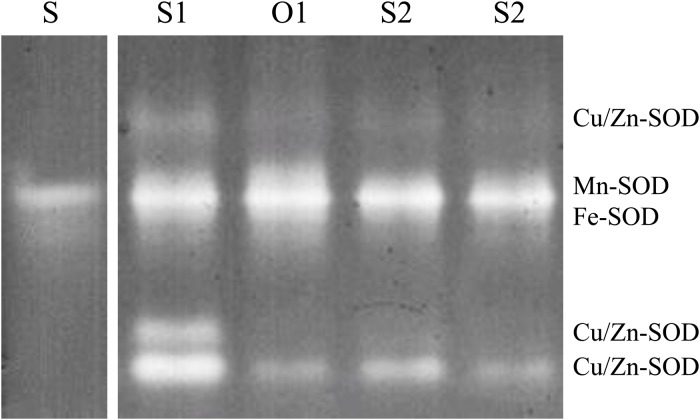
Superoxide dismutase (SOD) activity in the leaves of young orange trees 150 days after Zn application (enriched on 68Zn) in different soils.Legend: Bovine SOD standard (S), ZnSO4 (S1), and ZnO (O1) in the sandy loam soil; ZnSO4 (S2) and ZnO (O2) in the clay soil.